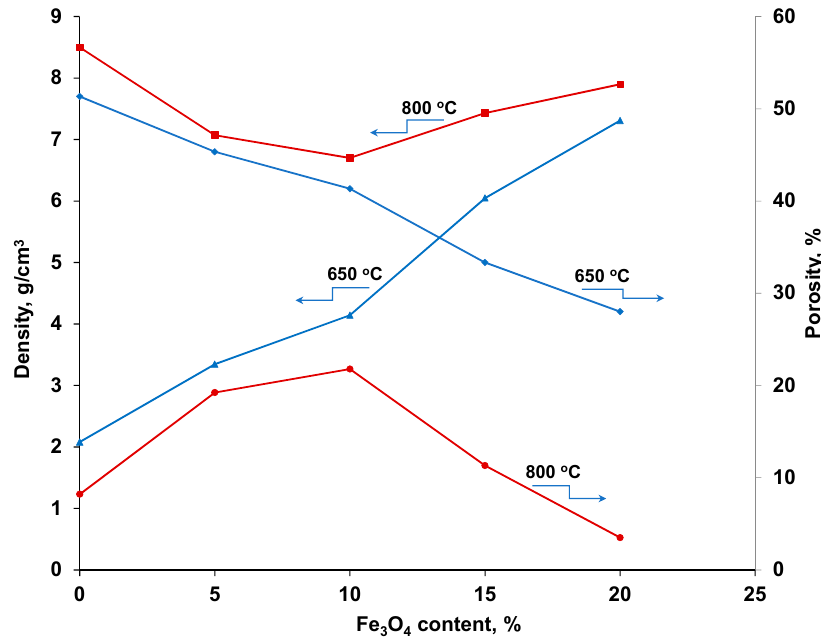
Figure 13. Variation of the density and porosity of composites as a function of the Fe 3 O 4 content.